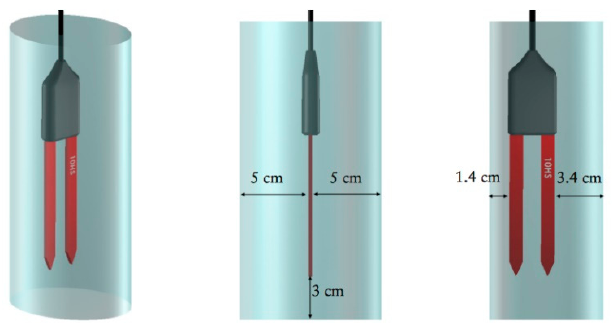
Figure 10. Idealized measurement volume of Decagon 10HS sensor.